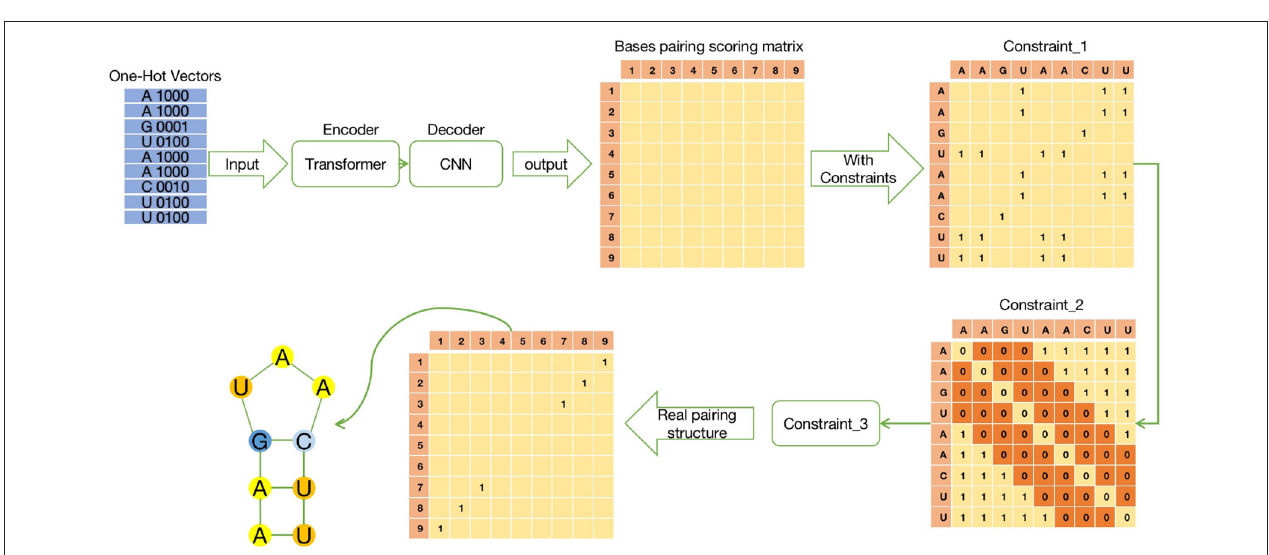
FIGURE 1 | The schematic diagram of ATTfold architecture, which contains three parts: Transformer, CNN, and Constrain. Transformer is an encoder network, mainly responsible for recoding the input One-Hot vectors of RNA sequences. CNN is a decoder network to predict the bases pairing scoring matrix. Constrain has three constraints to constrain the bases pairing scoring matrix and get the real secondary structure.